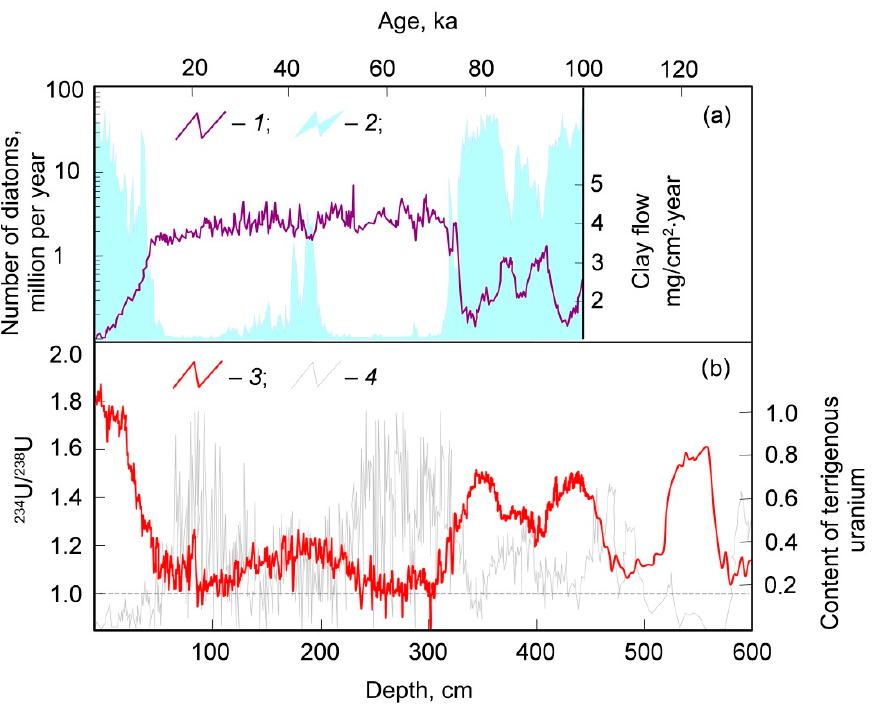
Figure 3. Distribution of various biological, clastic and isotope-geochemical indicators over the depth of bottom sediments of Lake Baikal (adapted with changes from [84,85]: 1—clay flow ( a ); 2—number of diatoms ( a ); 3— 234 U/ 238 U ratio ( b ); 4—concentration of terrigenous uranium ( b ).